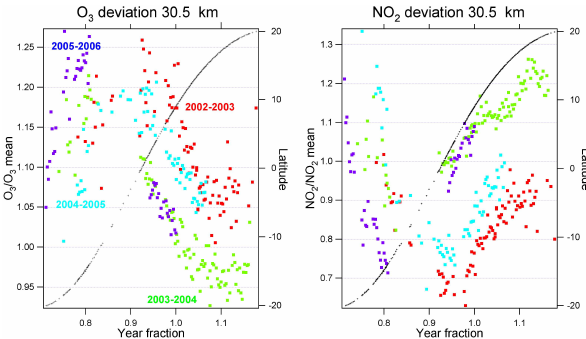
Fig. 3. Evolution of NO 2 and O 3 mixing ratios at 30.5km obtained from star S029 (Beta Carinae) occultations as a function of the frac- tion of the year (numbers greater than 1 indicates dates after 1st January). Concentrations have been divided by the mean value at 30.5km for the full